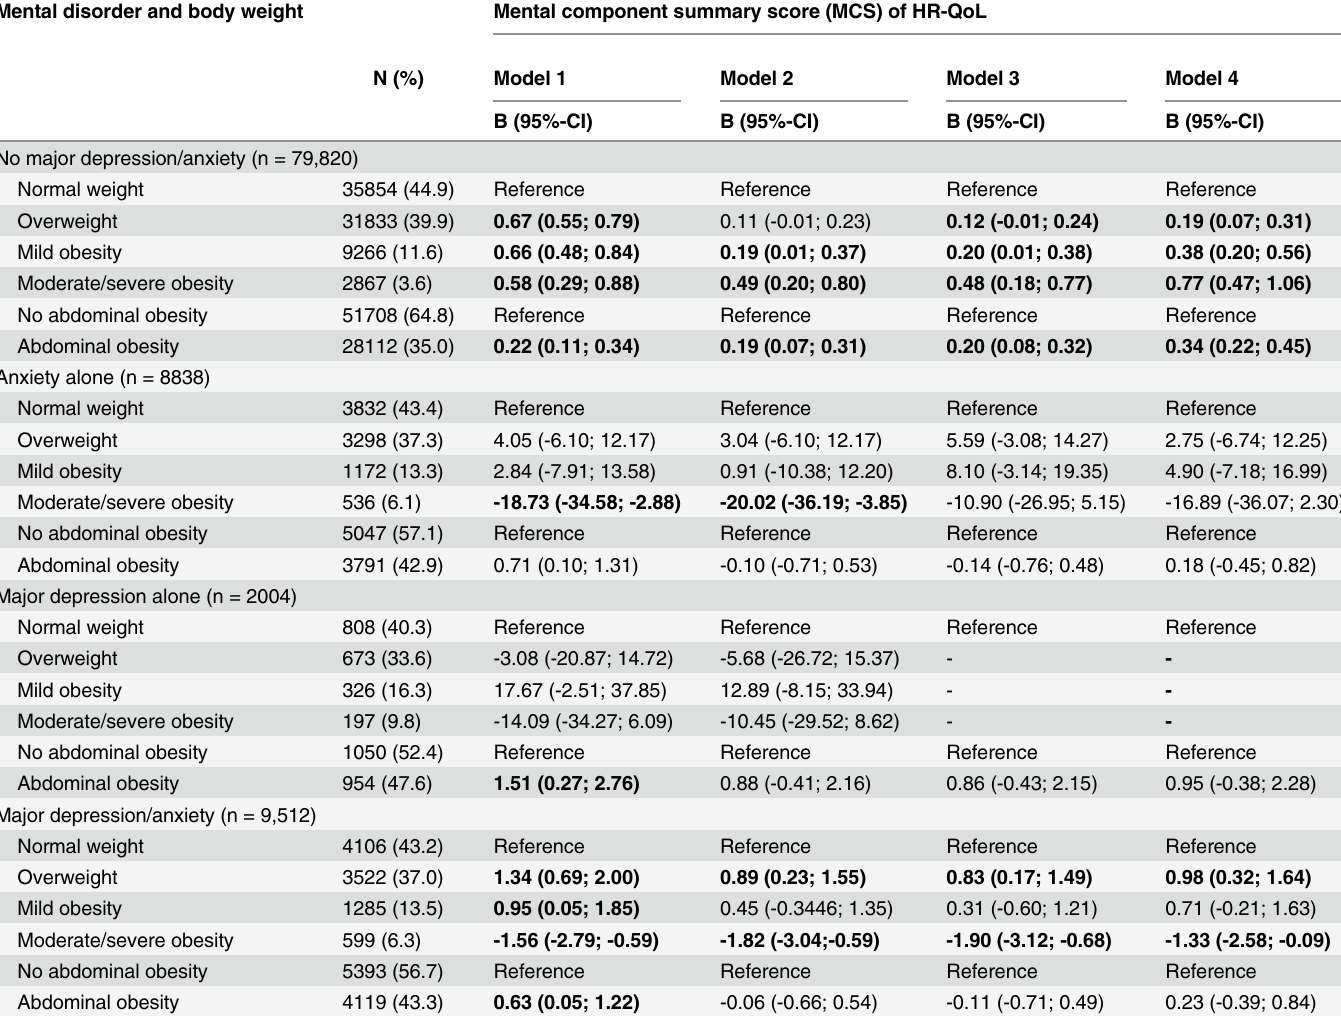
Table 5. Crude and adjusted regression coefficients (B) for mental quality of life with general and abdominal obesity categories stratified by major